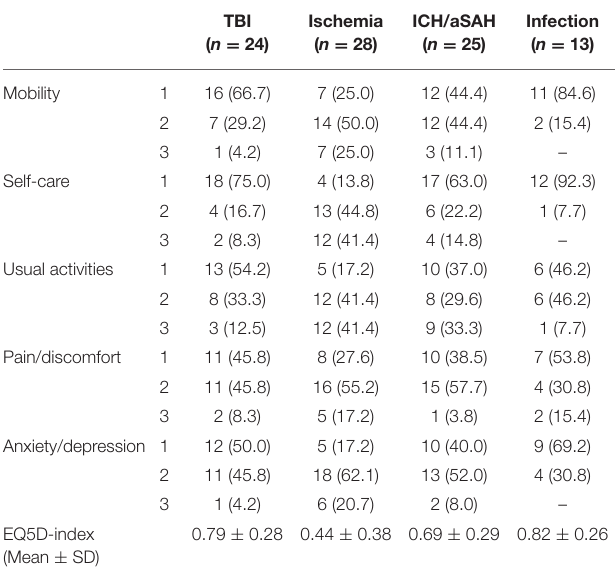
TABLE 3 | Results of EQ-5D-3L for all indication groups. TABLE 4 | Cosmetic result after CP divided in patient specific implant (PSI) and